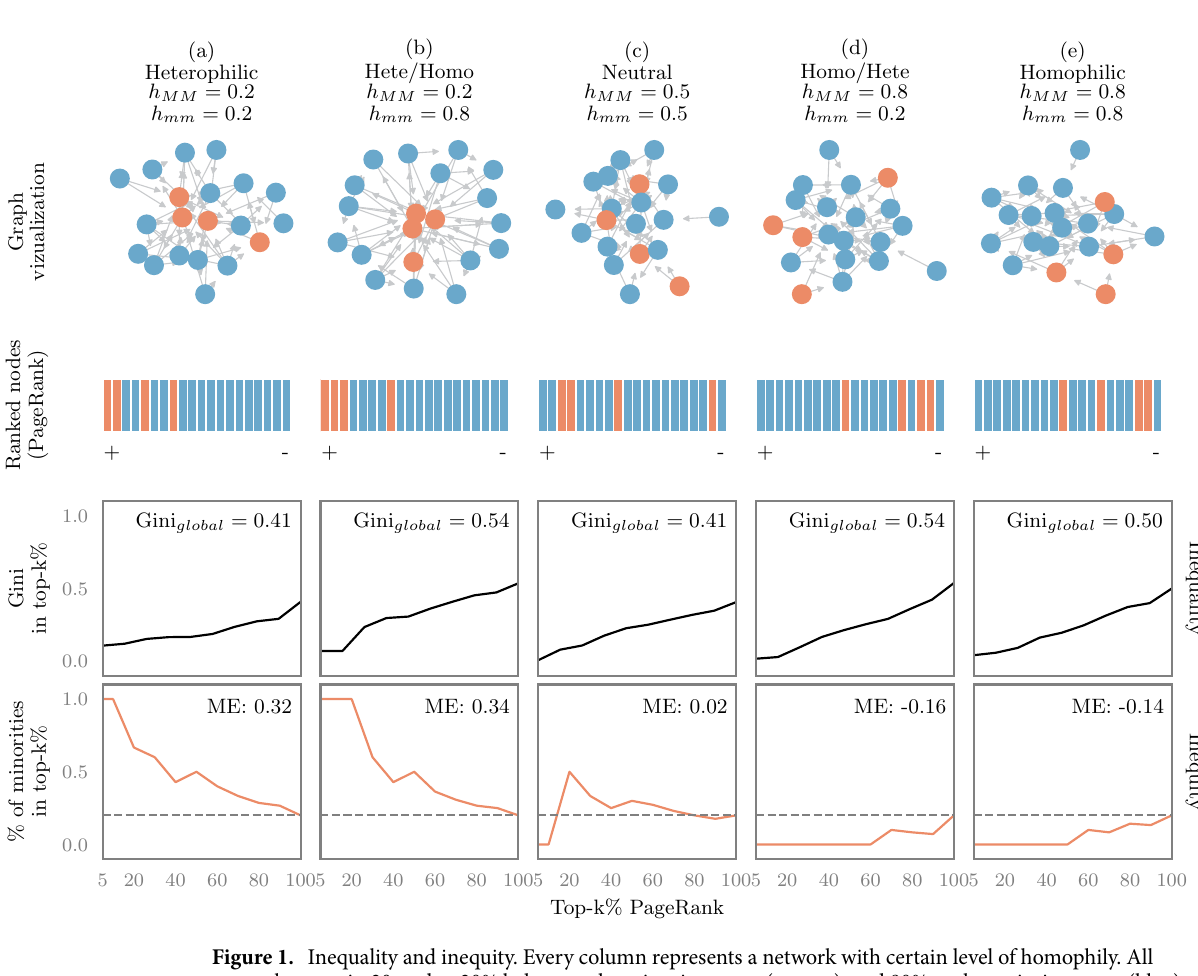
Figure 1. Inequality and inequity. Every column represents a network with certain level of homophily. All networks contain 20 nodes: 20% belong to the minority group (orange), and 80% to the majority group (blue). Edges follow a preferential attachment with homophily mechanism. The top row shows the graph and the level of homophily within groups ( MM : majorities and mm : minorities). The second row shows all nodes in descending order (from + to −) based on their PageRank scores. The third row represents the rank inequality : Gini coefficients of the rank distribution for every top − k % (black line). Gini global refers to the Gini coefficient of the entire rank distribution (i.e., at top- 100% ). We see that the lower the k , the lower the Gini of the rank distribution. The bottom row represents the rank inequity : Percentage of minorities found in each top- k % of the rank distribution (orange line). ME is the mean error of these percentages compared to a fair baseline or diversity constraint (i.e., how much the orange line deviates from the dotted line across all top-k’s). Here we see three main patterns: ( a , b ) When the majority group is heterophilic, minorities are on average over-represented, ME > 0.0 . ( d , e ) When majorities are homophilic, minorities are on average under-represented, ME < 0.0 . ( c ) When both groups are neutral, the observed fraction of minorities is almost as expected, ME ≈ 0